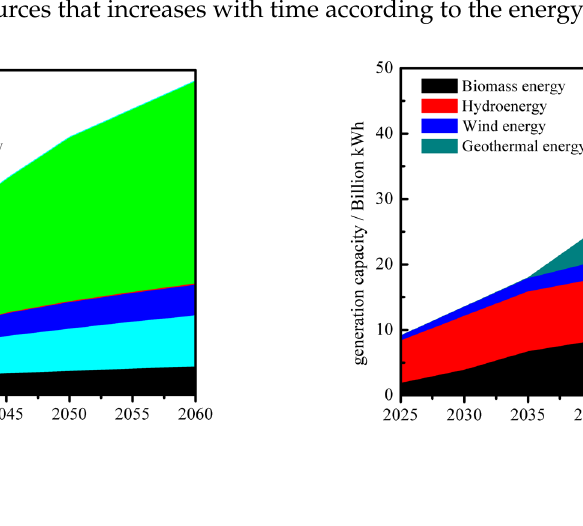
Figure 7. Renewable energy development forecast in rural areas of Guangdong province. ( a ) solar power; ( b ) biomass, hydropower, wind and geothermal energy generation in the province from renewable energy technology development and economic forecasts.